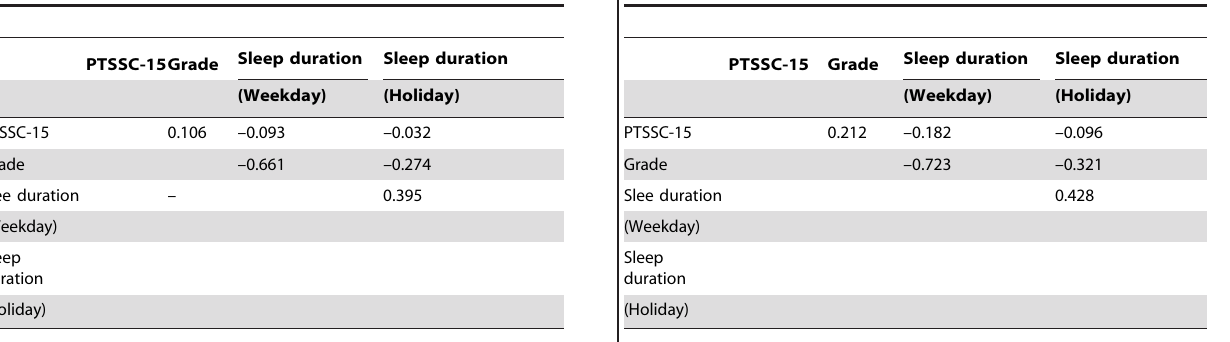
Table 5. Correlations between PTSSC-15, grade, and sleep durations on weekends and holidays in male children.